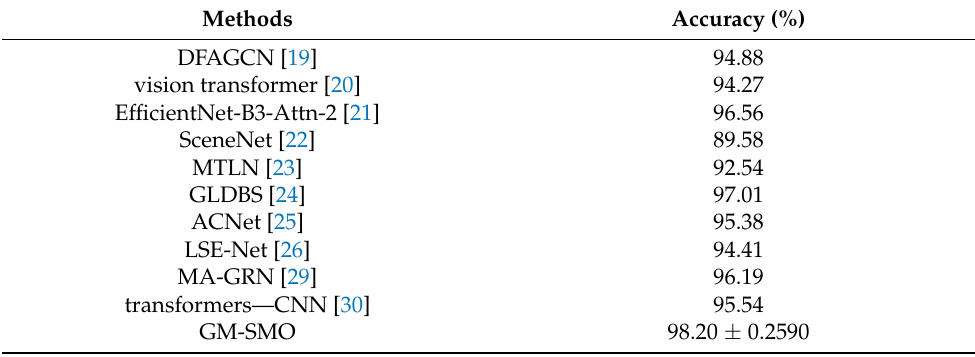
Table 6. GM-SMO method comparison with existing methods on AID dataset.